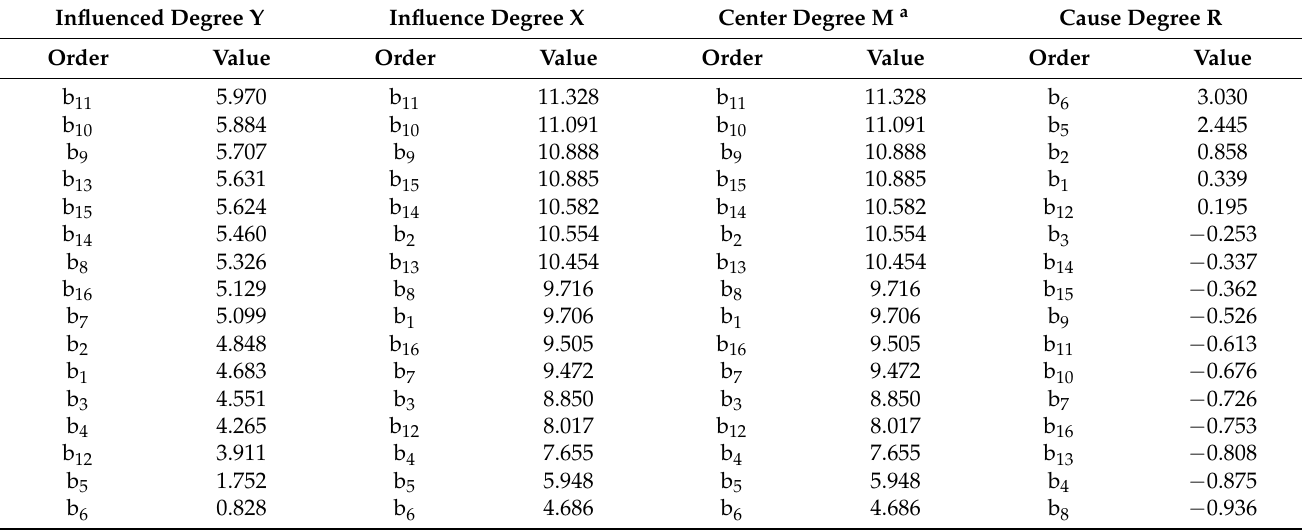
Table 6. Centrality and cause